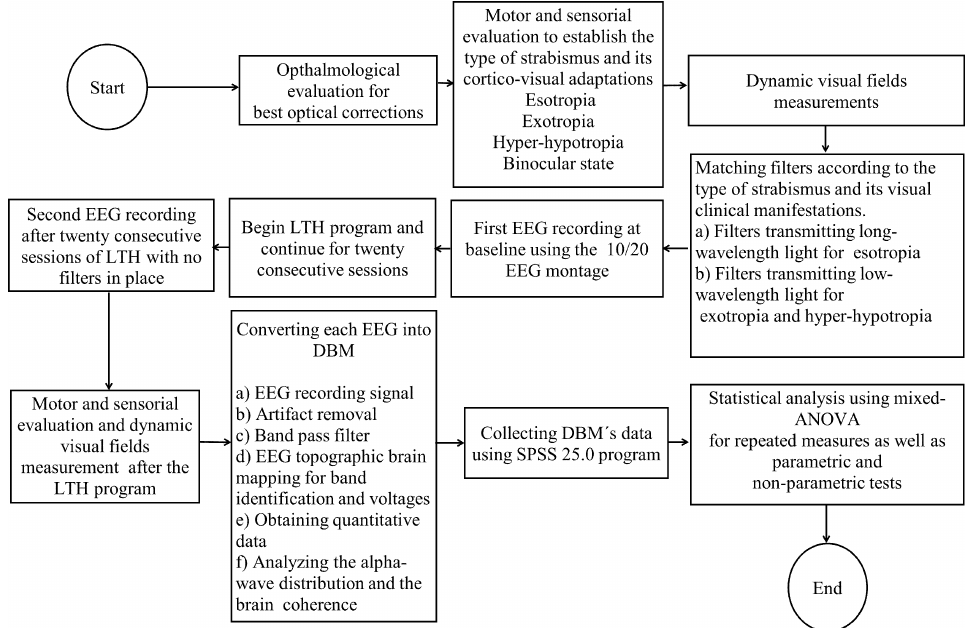
Figure 2. The flow diagram illustrates the steps followed in this